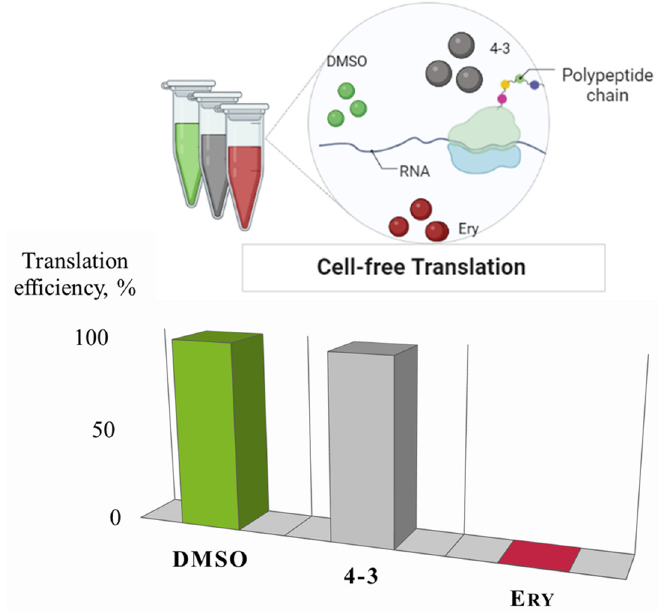
Figure 5. General scheme of cell-free translation assay ( top ) and translation effectiveness ( bottom ) in the presence of sample 4-3, DMSO 1% (negative control) and erythromycin (Ery, 5 µ g/mL) as positive control.